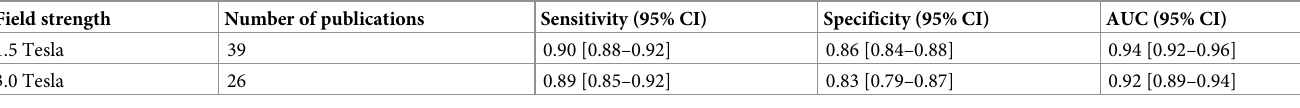
Table 4. Additional analysis: 1.5 vs. 3.0 Tesla, pooled sensitivity and specificity.